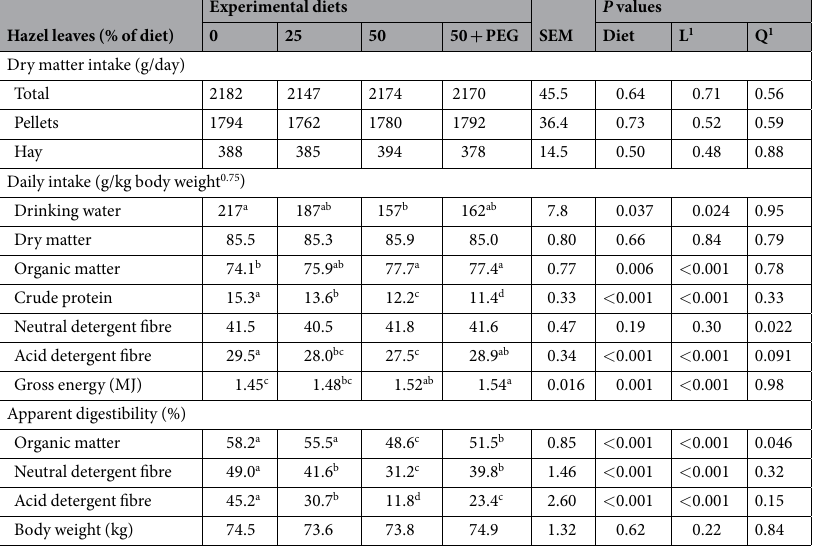
Table 2. Effect of hazel leaves on intake, nutrient digestibility and body weight of the sheep (n = 6). L, linear effect of hazel leaf proportion; PEG, polyethylene glycol; Q, quadratic effect of hazel leaf proportion; SEM, standard error of mean. Means carrying no common superscript are different at P < 0.05. 1 For this analysis, only diets 0, 25 and 50 were